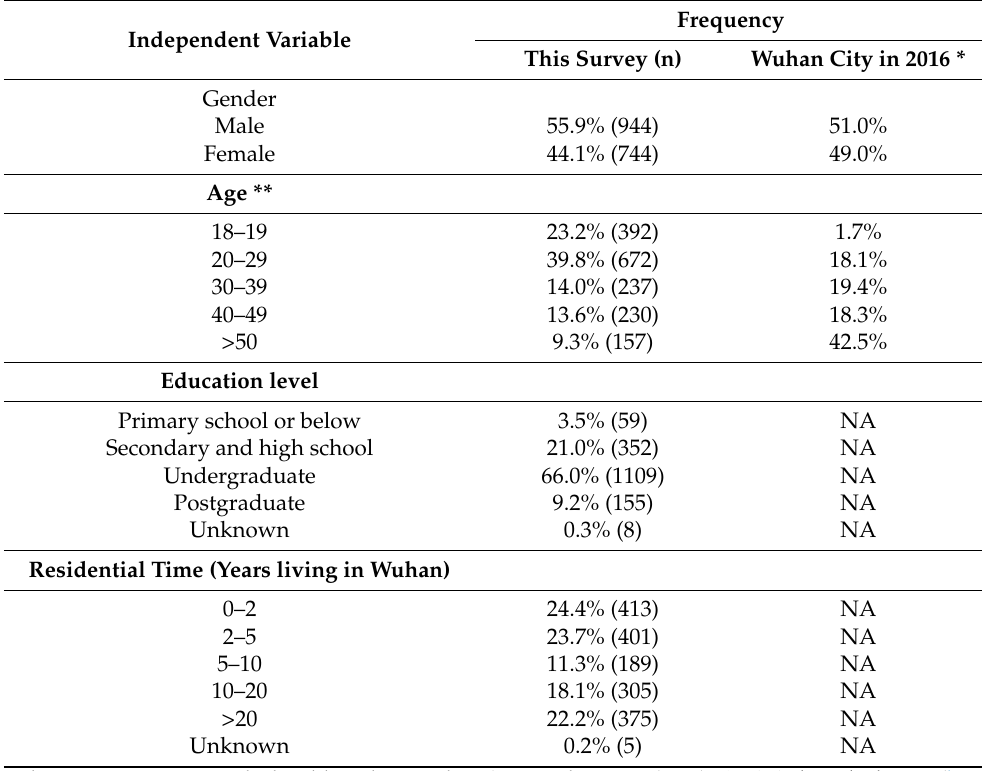
Table 2. A comparison of demographic distribution for surveyed participants and Wuhan